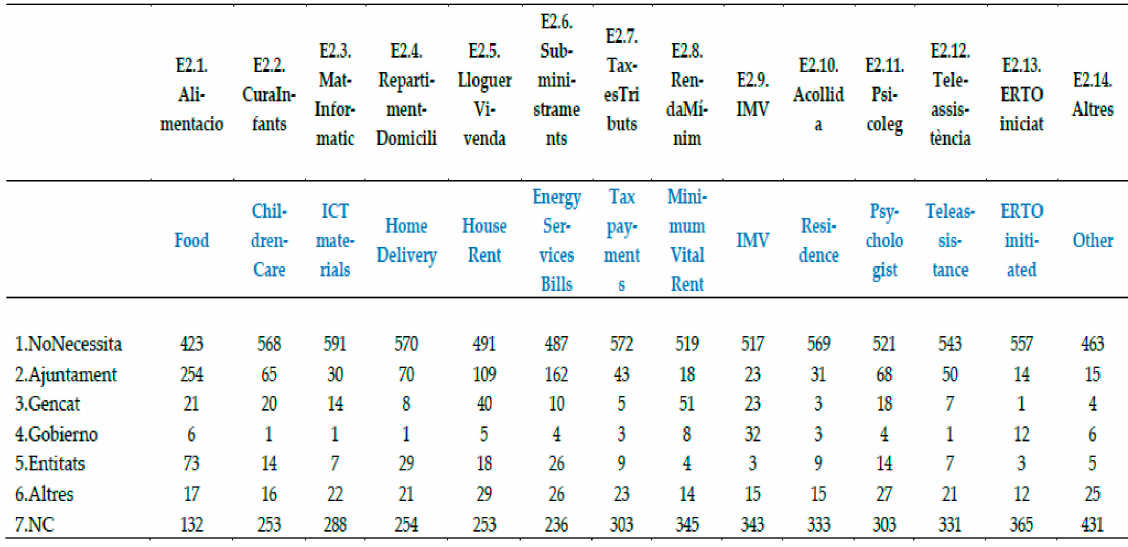
Figure 25. Cross table of E2.AjutsCOVID19 (Subsidies per COVID19) per